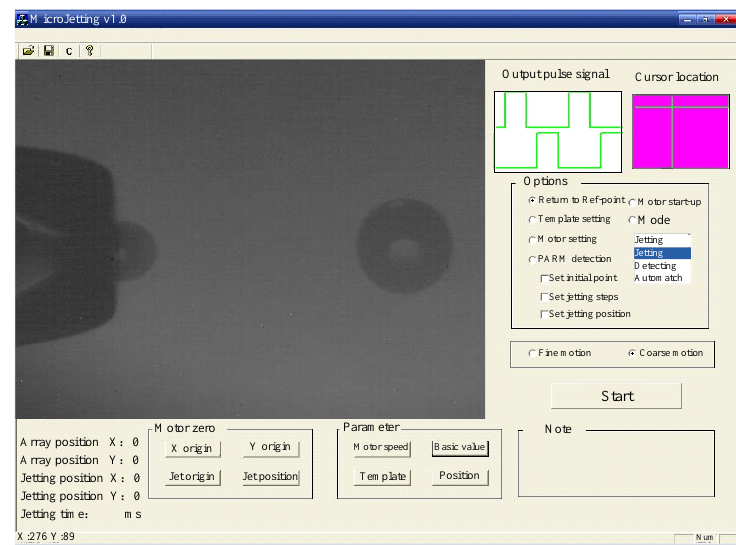
Figure 5. Pulse signal for solenoid valve and external trigger signal for charge-coupled device (CCD).